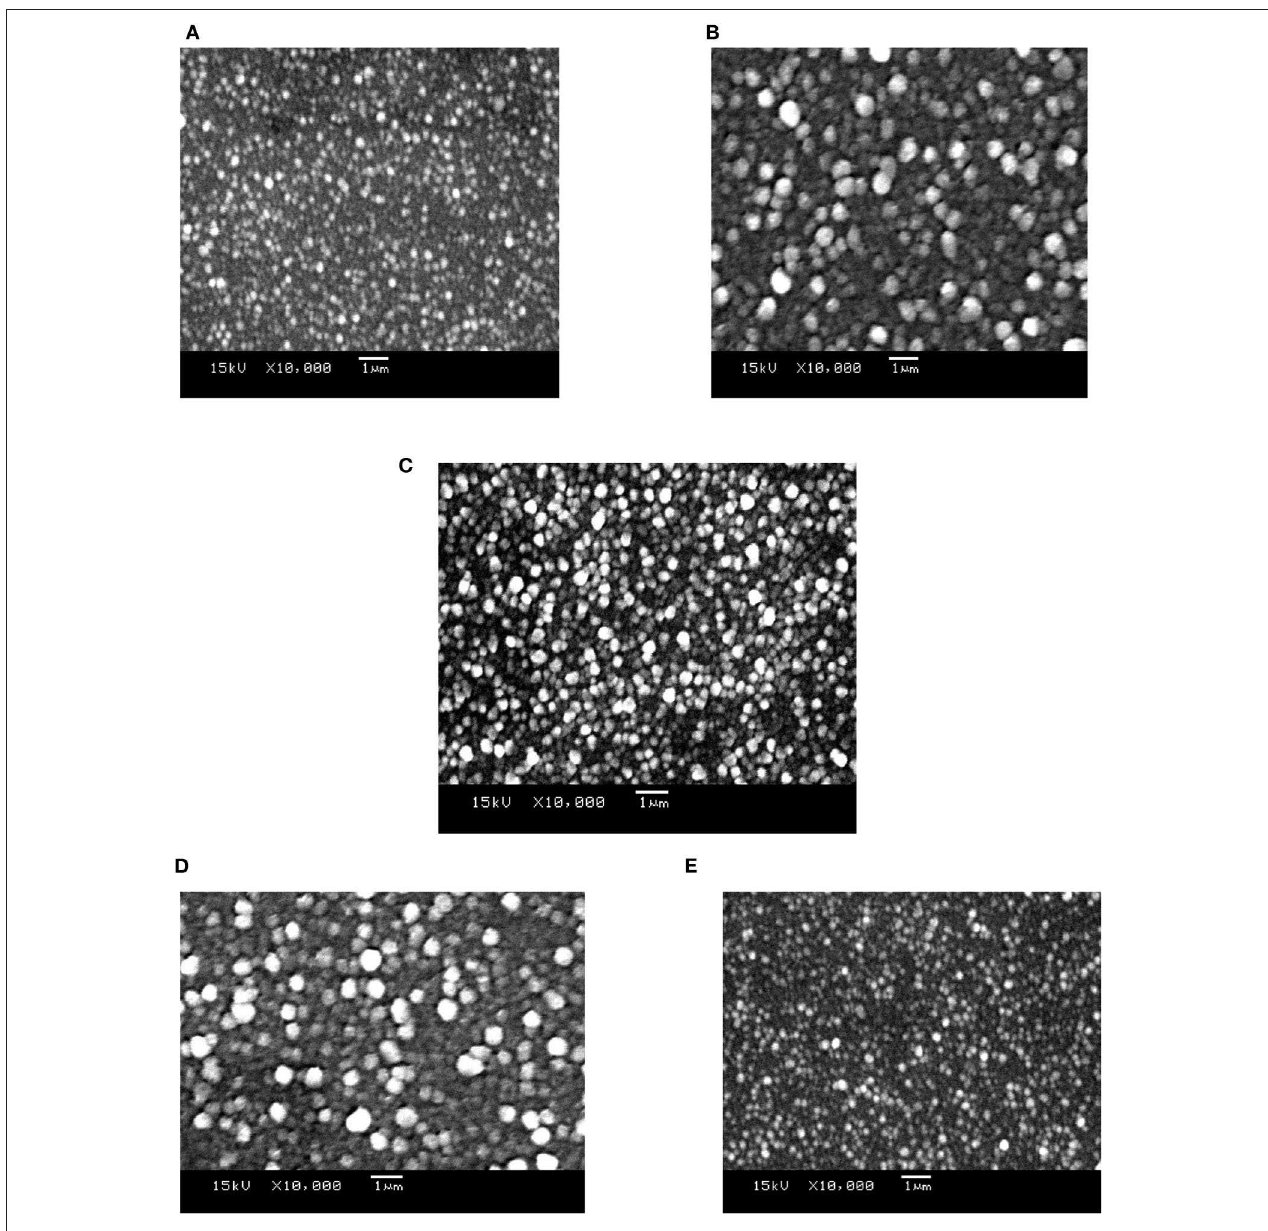
FIGURE 3 | The SEM patterns of InN films at various N 2 flux for (A) 60 sccm, (B) 70 sccm, (C) 80 sccm, (D) 90 sccm, and (E) 100 sccm,